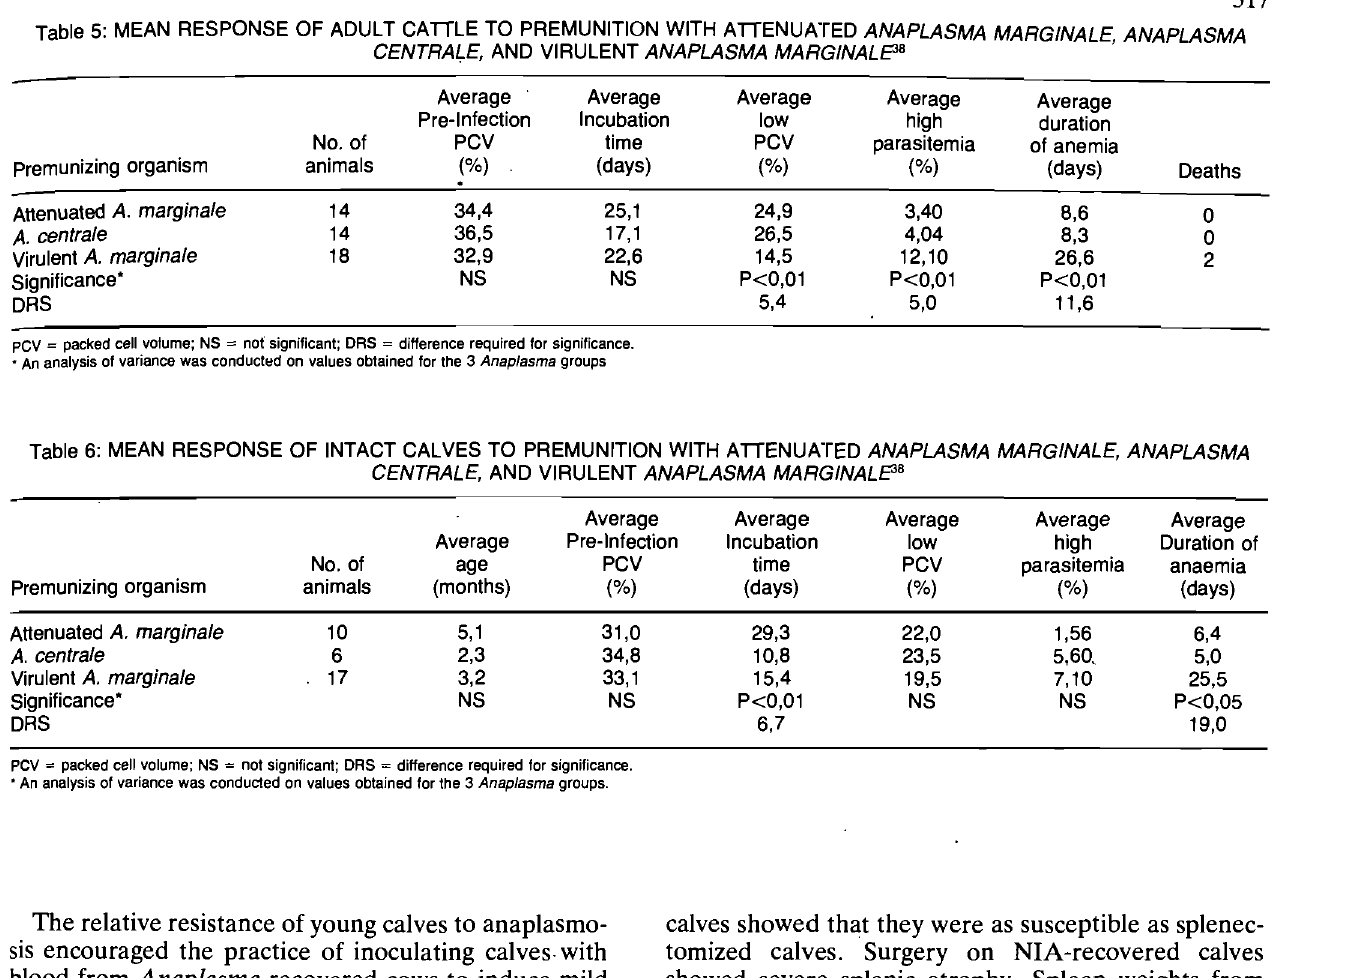
Table 6: MEAN RESPONSE OF INTACT CALVES TO PREMUNITION WITH ATTENUATED ANAPLASMA MARGINALE, ANAPLASMA CENTRALE, AND VIRULENT ANAPLASMA